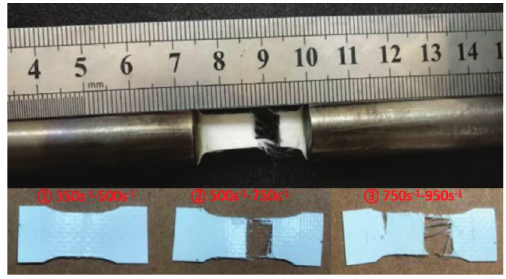
Figure 4: Typical failure mode under the strain-rate